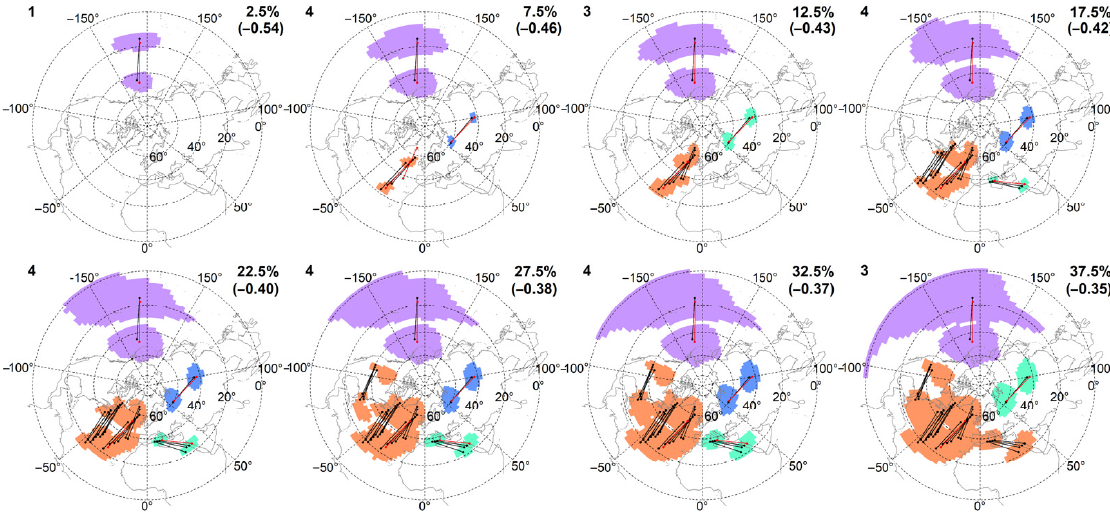
Figure 1. CP maps obtained from the ERA-20C for the period 1971–2000 over the NH. Each cluster is plotted with different color. The PotACs are visualized with black dots connected with black lines. (On average, 40 PotACs with an associated correlation below − 0.3 can be obtained in each period). The PotAC with the most intense SNC in each cluster is highlighted with red. The numbers of clusters can be found in the top-left corner of the maps. The percentile of all SNCs and its value (below which the SNCs are taken into account to create the CP map) are shown in the top-right corner of each map. The associated data are available in Table S1 of the Supplementary Material. The SNC fields with the PotACs of the reanalyses and the GCMs in all time periods and a selection of CPs obtained from the reanalyses and the GCMs are available from the first author upon